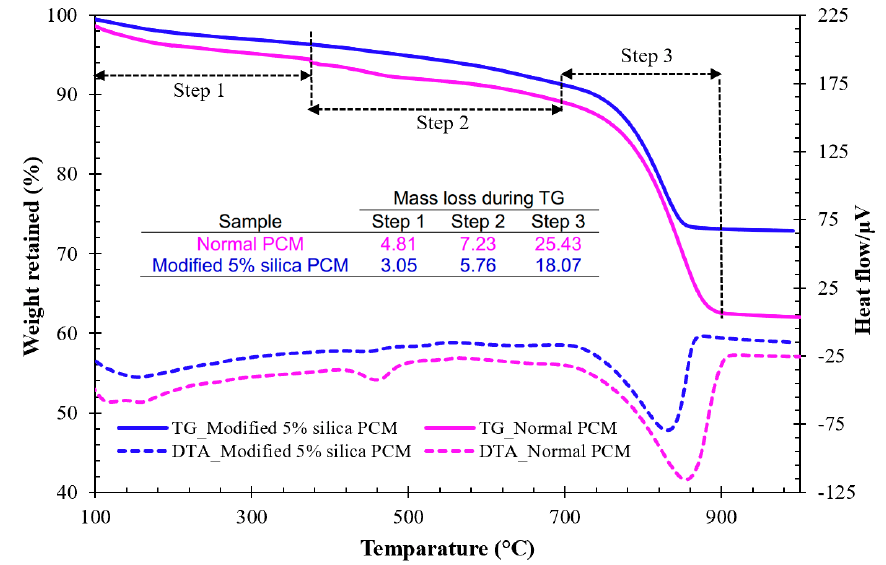
Figure 7. TG-DTA curve of the sample collected from the interface of composite specimen.